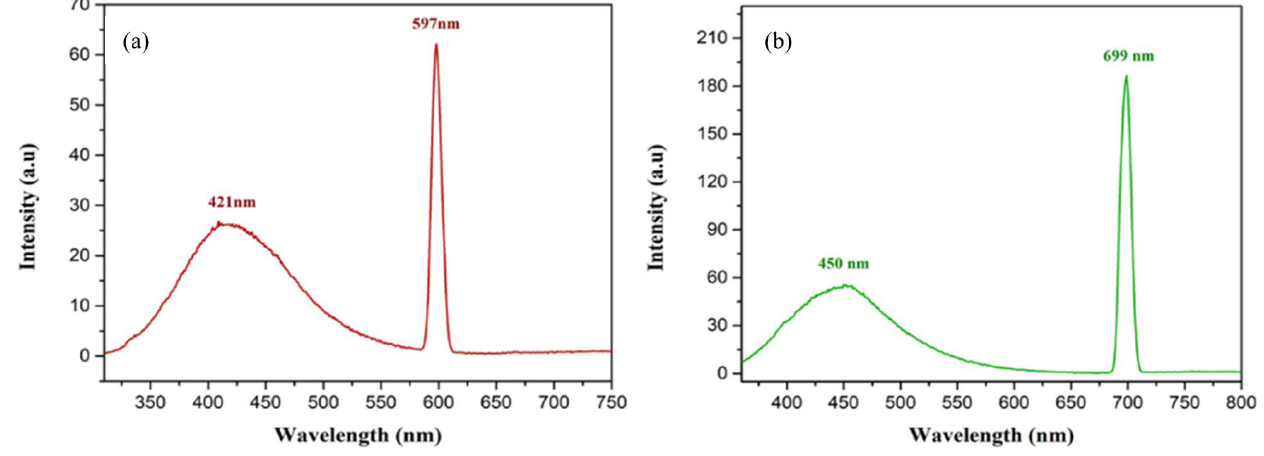
Figure 5. PL spectra of biogenic CuO NPs at: ( a ) 300 nm, ( b ) 350 nm.